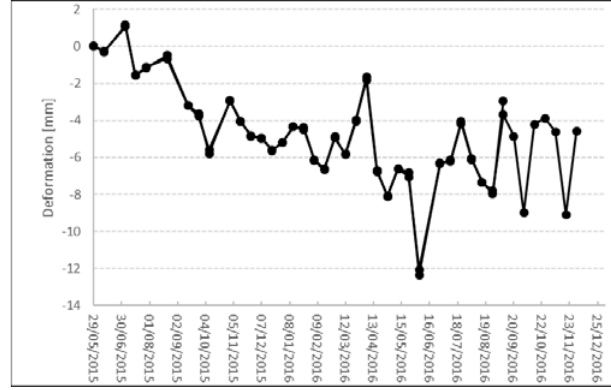
Figure 3. Deformation time series of point 1, whose location is shown in Figure 2.